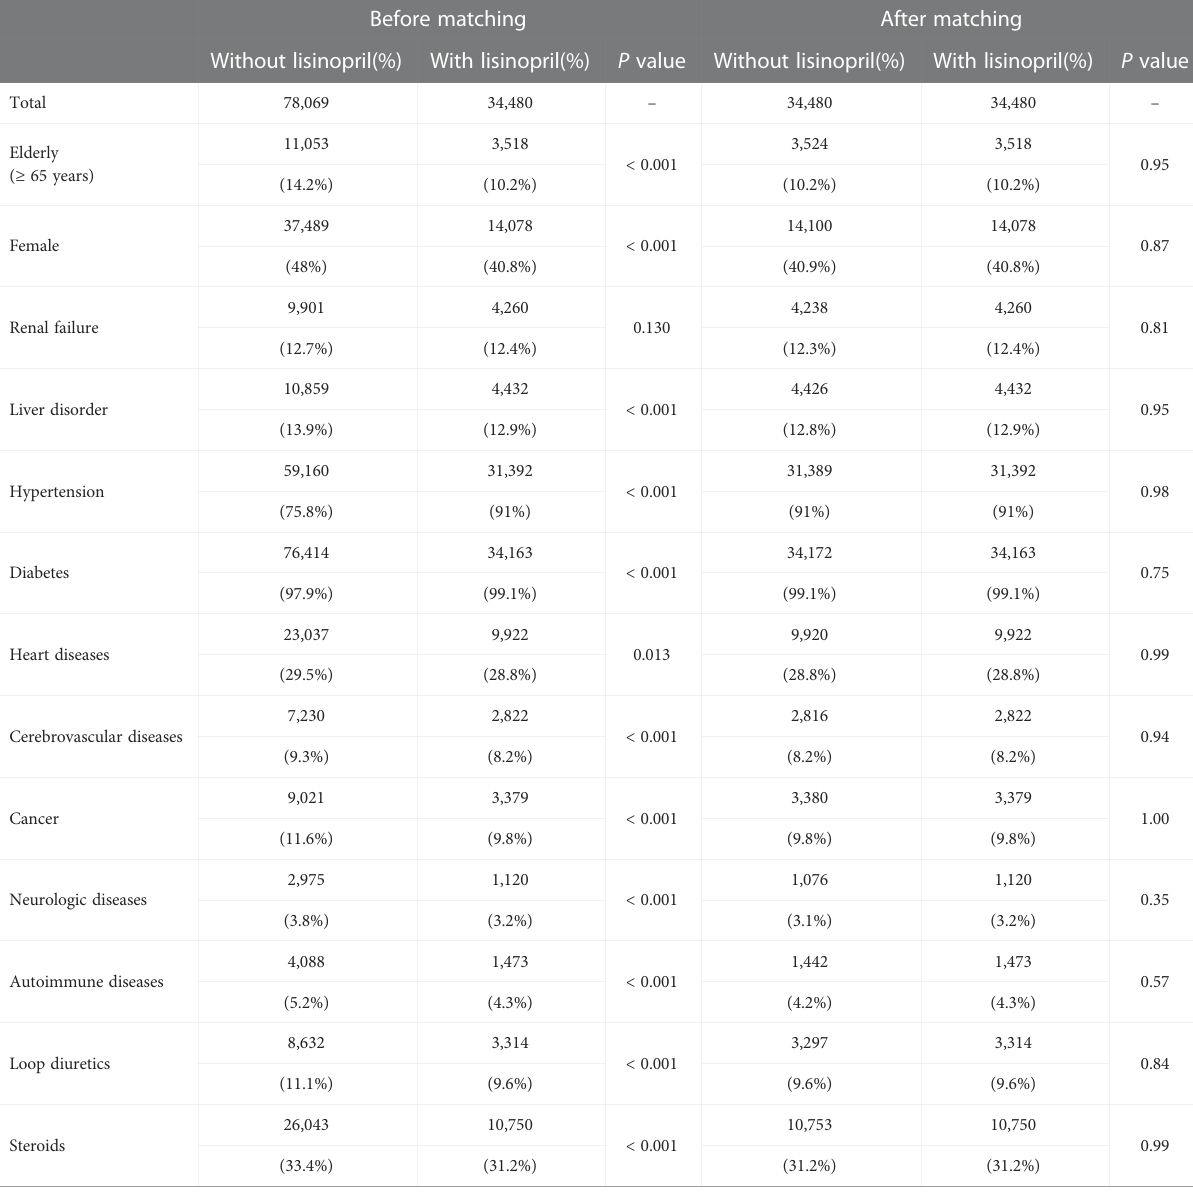
TABLE 4 Propensity score matching of cohorts receiving DPP4 inhibitors in the MarketScan database. The number and percentage of patients in each group are shown. Before matching After matching Without